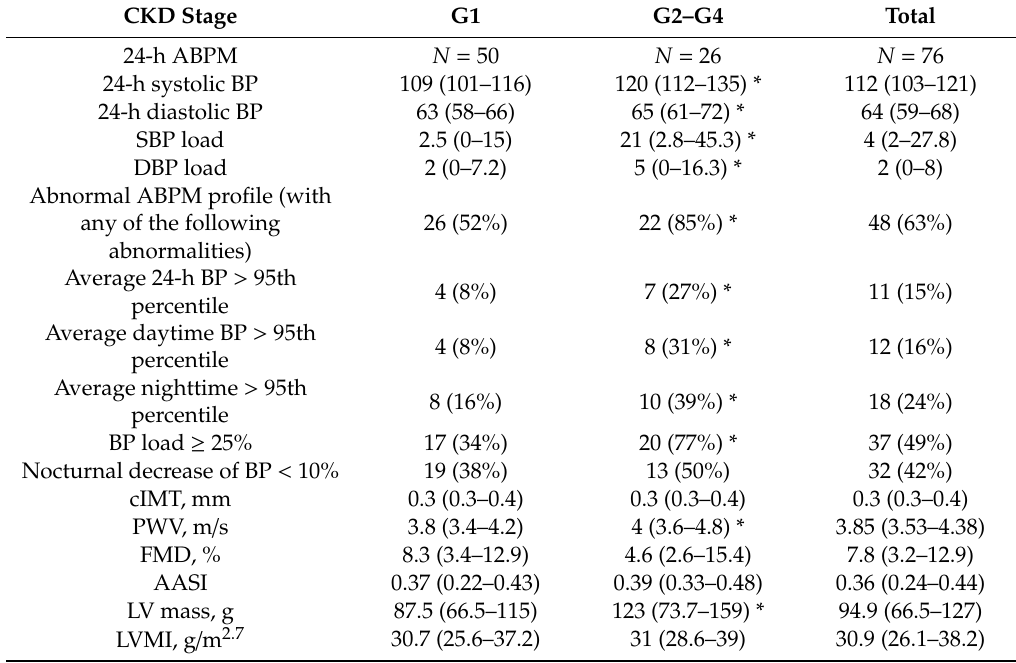
Table 3. Cardiovascular characteristics in children and adolescents with